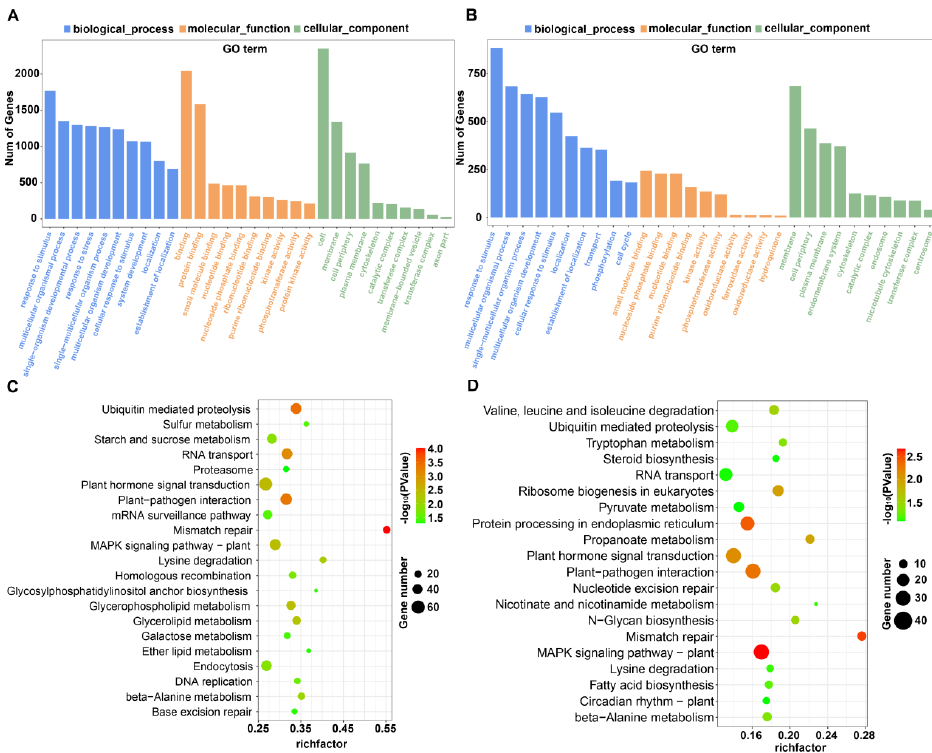
Figure 2. GO and KEGG pathway enrichment analysis results of salt-responsive miRNA target genes. ( A ) GO enrichment results for target genes of DE-miRNAs in M82. ( B ) GO enrichment results for target genes of DE-miRNAs in Solanum pennellii ( S. pennellii ). ( C ) KEGG enrichment results for target genes of DE-miRNAs in M82. ( D ) KEGG enrichment results for target genes of DE-miRNAs in S. pennellii .